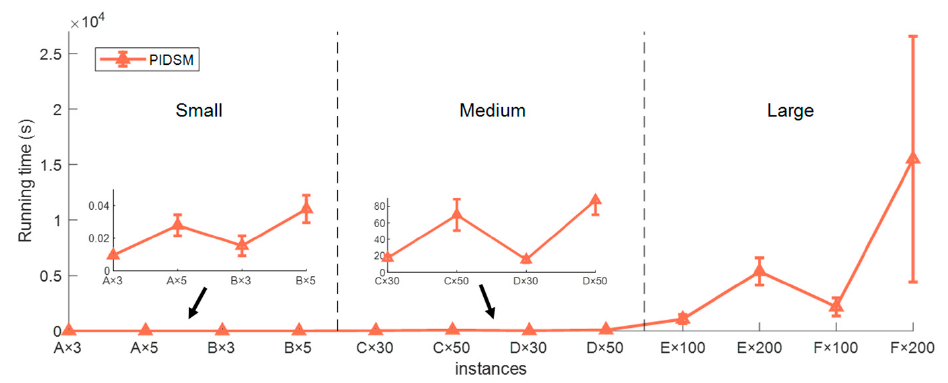
Figure 11. The results of running time.